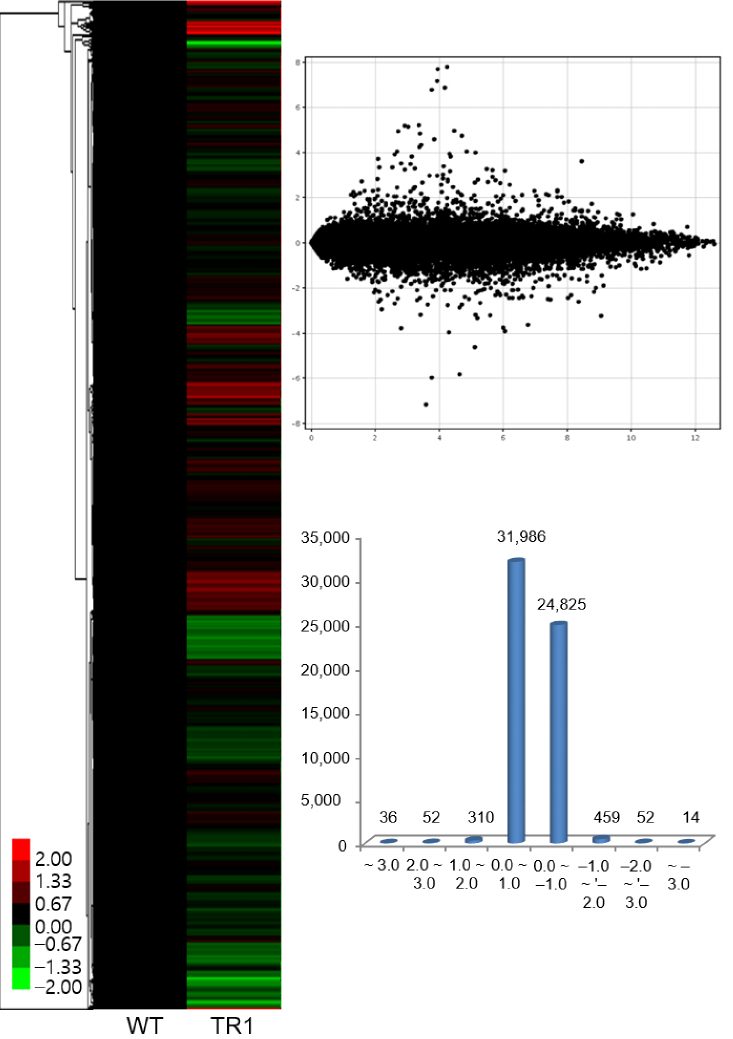
Figure 4. Microarray-based expression profiles of transgenic and wild-type rice plants. Microarray analysis was performed in order to determine the gene expression profiles of transgenic rice (TR) plants grown under the natural paddy fields. Heat map ( left ) and numbers ( right ) of up- and downregulated genes. WT, wild-type rice; TR, transgenic rice. Marked characteristics are annotated in Supplementary Tables S3 and